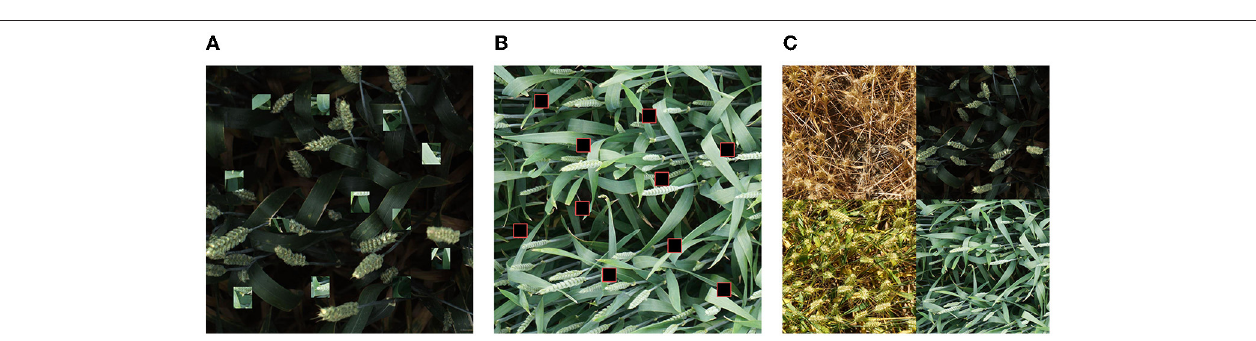
FIGURE 3 | Training samples with different sparsity levels of the detection box number: (A) 9 boxes; (B) 19 boxes; (C) 37 boxes.